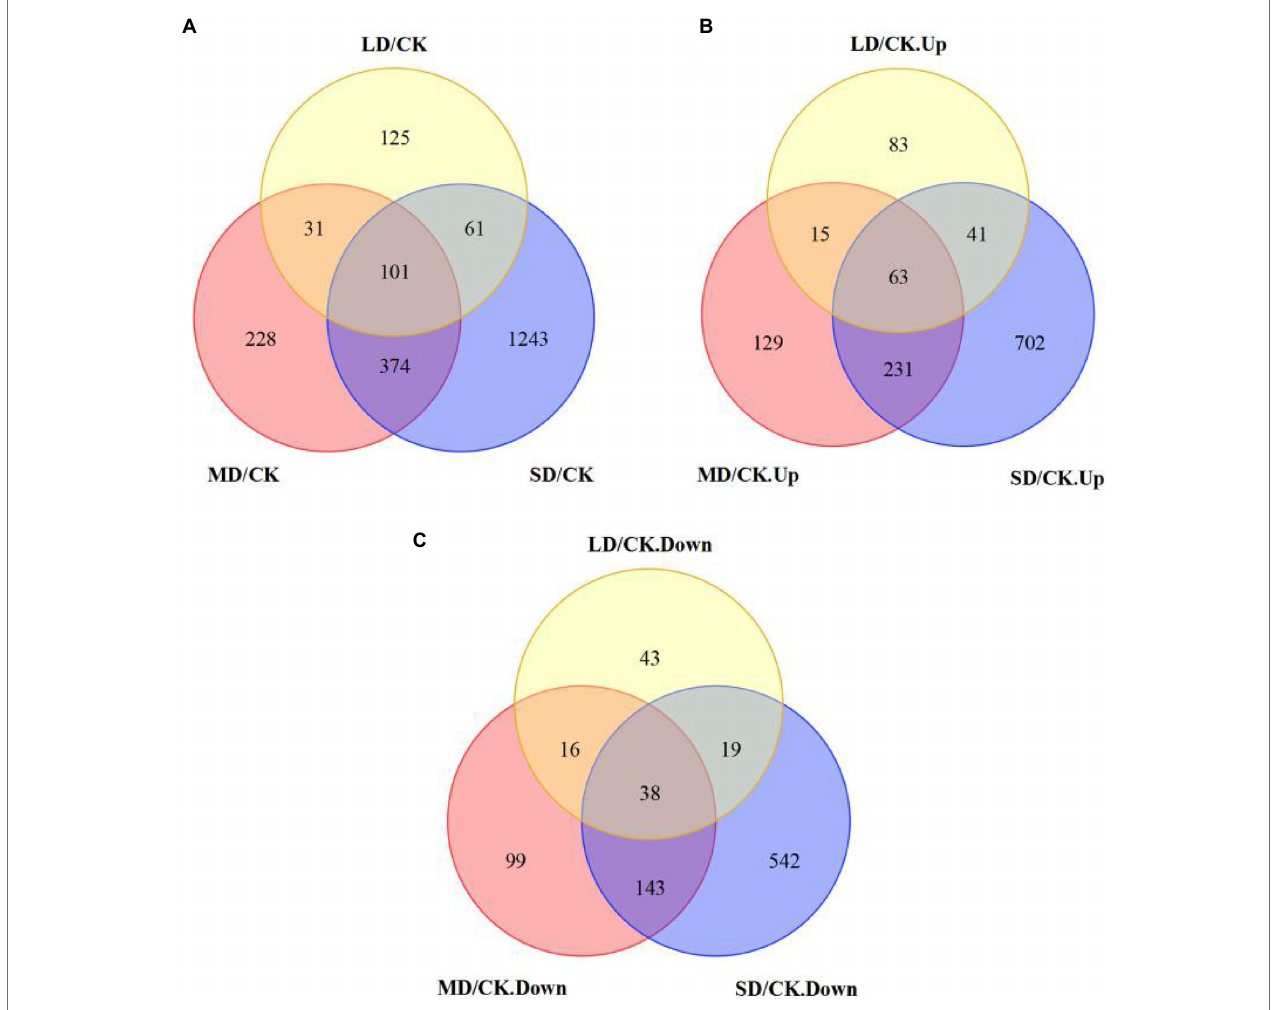
FIGURE 6 | Five differentially expressed genes (DEGs) shown in Venn diagram form. (A) Venn diagram showing the total number of total DEGs, (B) only upregulated DEGs and (C) only downregulated DEGs in S. davidii in the LD/CK, MD/CK and SD/CK comparison